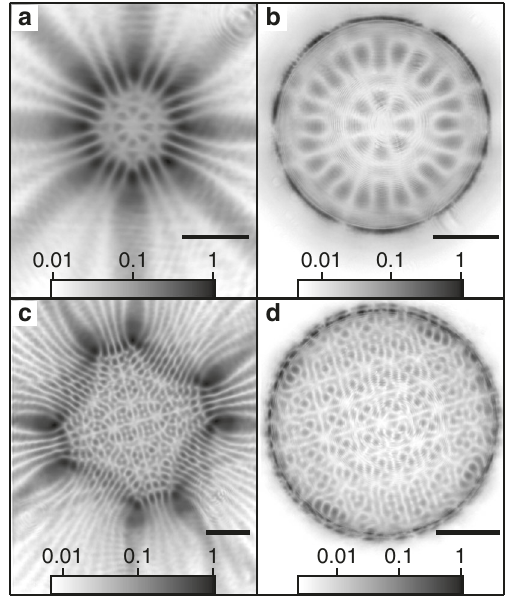
Fig. 6 Experimental polariton condensate PL using eight pump spots forming a circle. Logarithmic colourmaps showing the a , c real-space and b , d k -space photoluminescence distributions where a , b and c , d show regular and dimerised octagons, respectively. The black lines are 15 μ m and 1 μ m − 1 scale bars in a , c and b , d ,